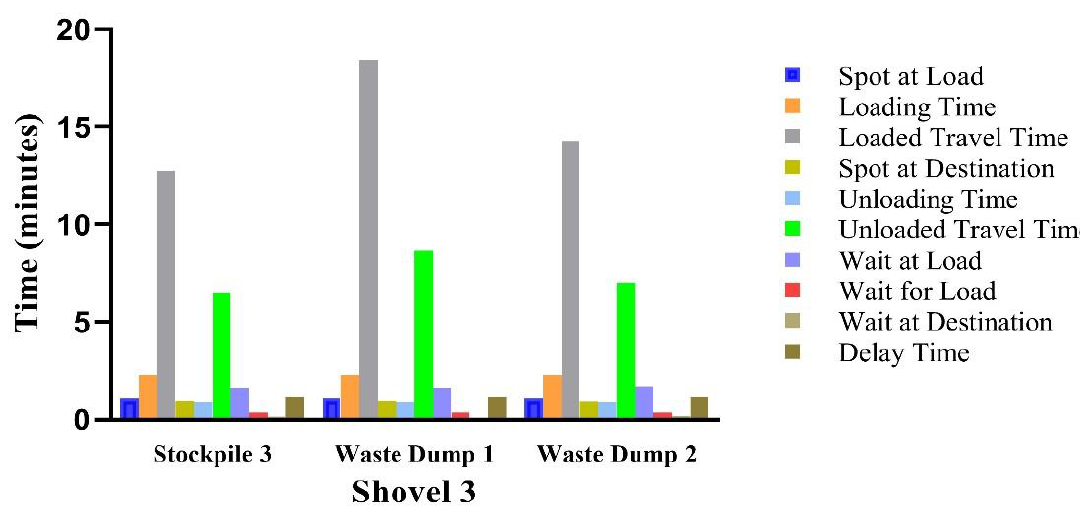
Figure 7. Total cycle time for trucks assigned to shovel 3.